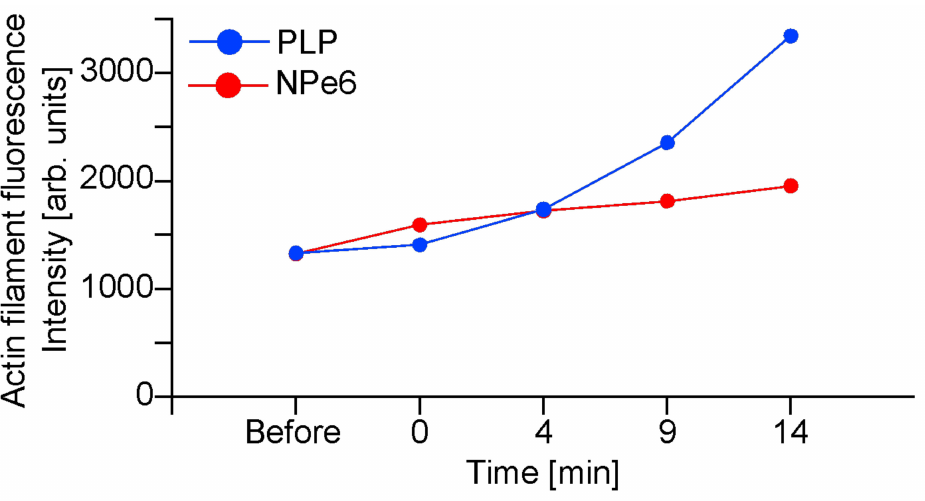
Figure 4. Results of quantifying the fluorescence intensity from the fluorescence observation images in Figure